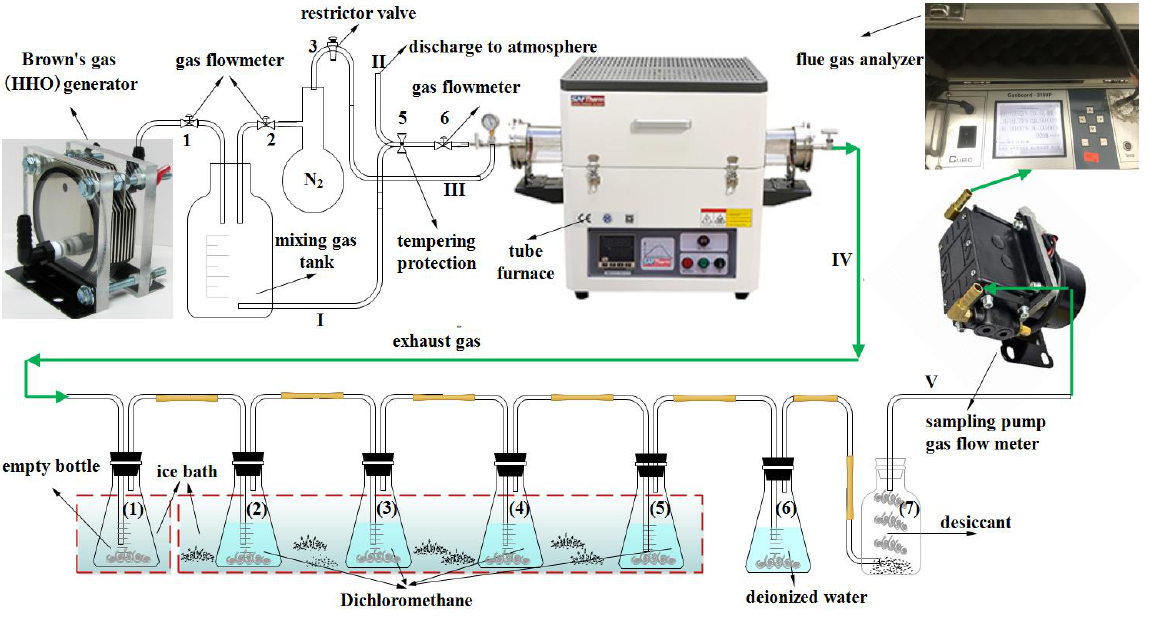
Figure 4. Experimental system for gas-phase tar cold trapping during the biomass pyrolysis (I, II, III, IV, and V represent gas path, respectively). Table 2. Elemental analysis of pine wood.